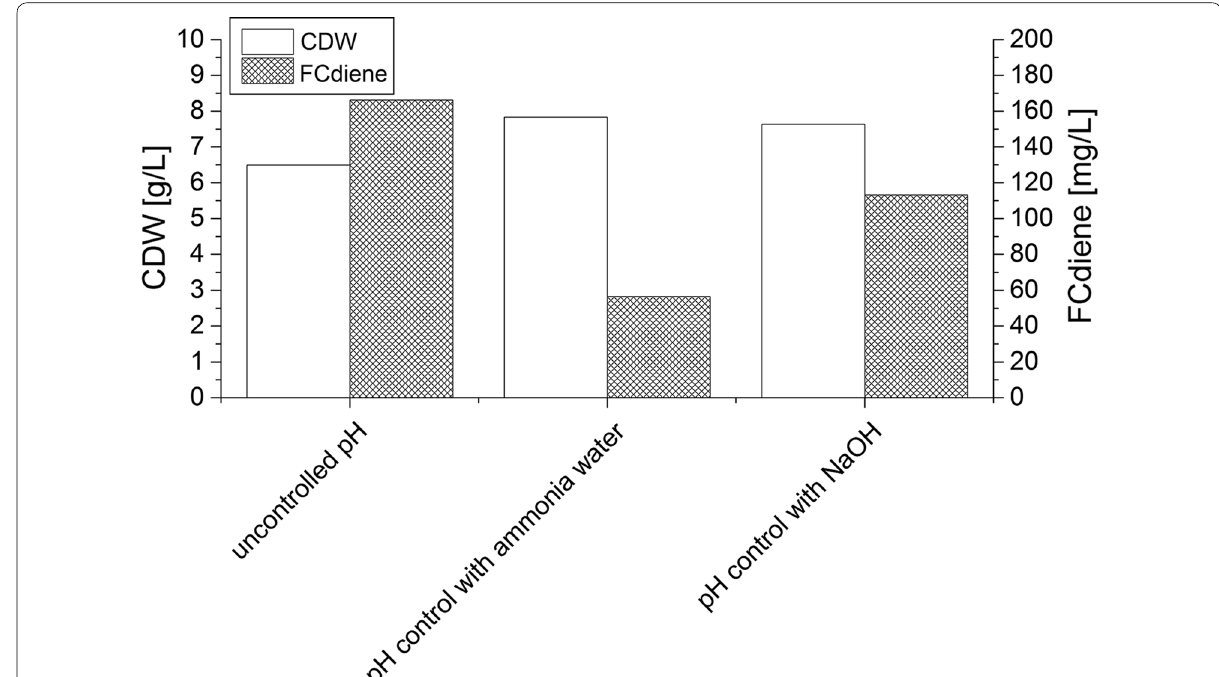
Fig. 6 pH influence on fed-batch fermentations of S. cerevisiae in a KLF2000 fermenter (working volume 1.8 L), using glucose as a carbon source. Cell dry weight and FCdiene concentrations measured at the end of the fermentations are shown